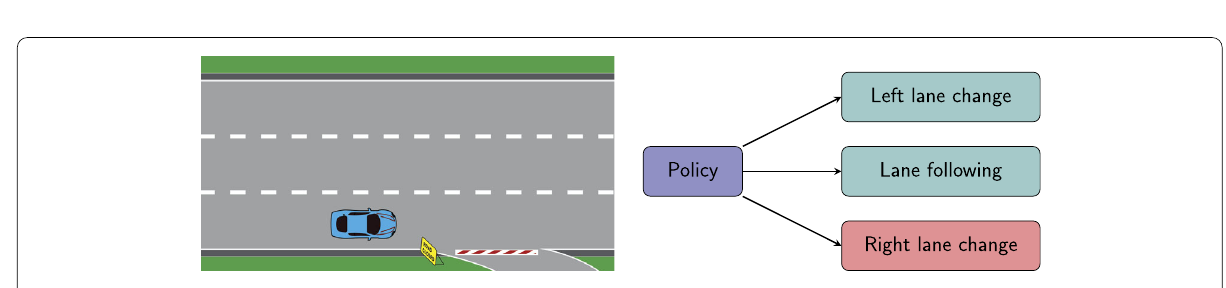
Figure 6 The benefit of memory. It is impossible to figure out the car’s heading without memory (6(a)), while it becomes straightforward with memory (6(b))